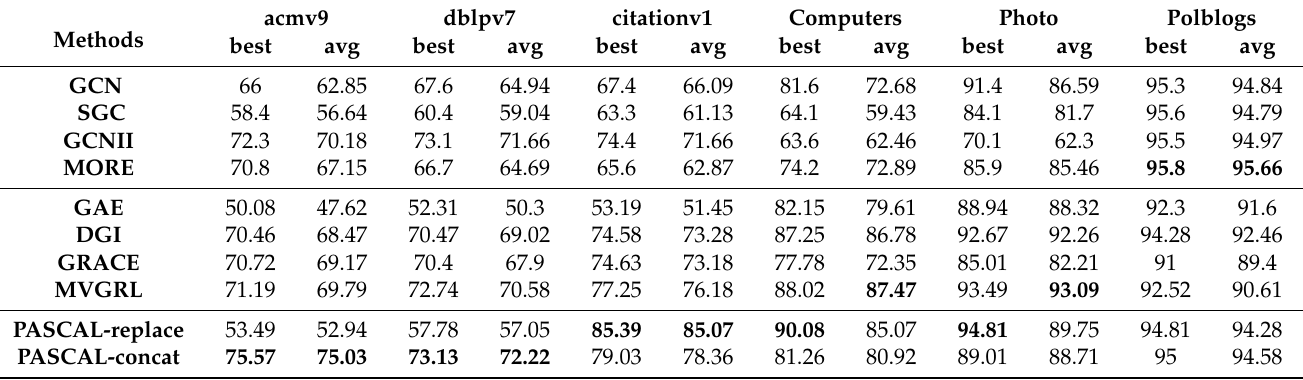
Table 4. Summary of node classification results on 6 datasets. All experiments are carried out 20 times, and “best” and “avg”, respectively, represent the best and average performance of the model. “PASCAL-replace” and “PASCAL-concate” represent the two PASCAL variants mentioned in Section 4.4 using different types of encoders. Bold numbers represent the best results on different